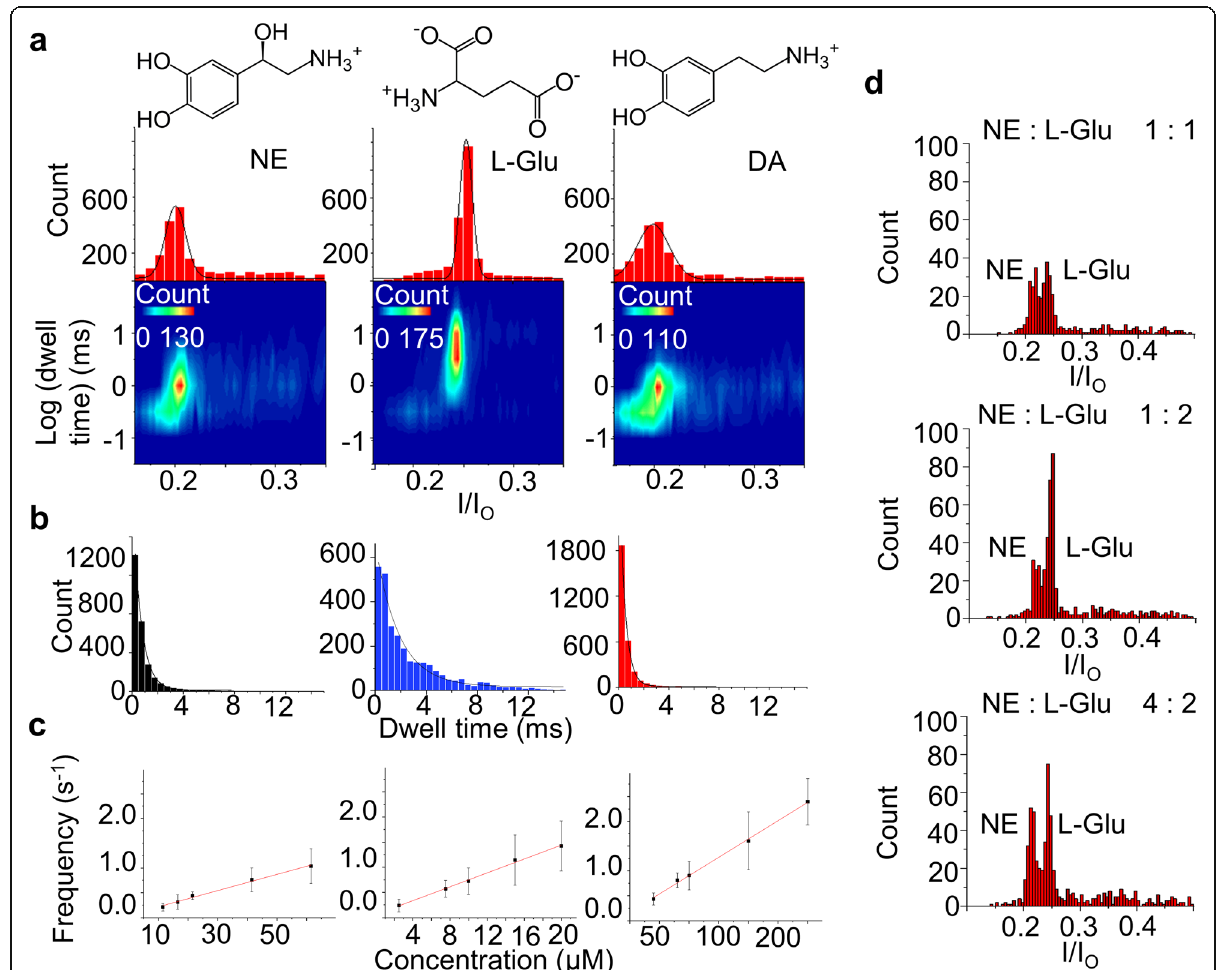
Fig. 3 Detection of NE, L-Glu, DA by the M2MspA-N91H nanopore. a 2D contour plots of blockade percentage versus log (dwell time) and blockade percentage histograms of NE, L-Glu and DA from left to right, concentrations: NE, 100 μ M; L-Glu, 20 μ M; DA, 100 μ M. b Event duration histograms of NE, L-Glu and DA fitted to exponential decay curves. c Concentration gradient experiments, showing first order dependence of event frequency on concentration of NE, L-Glu and DA (linear fit, R 2 = 0.990, 0.995, 0.997). d Blockade percentage histograms of NE and L-Glu